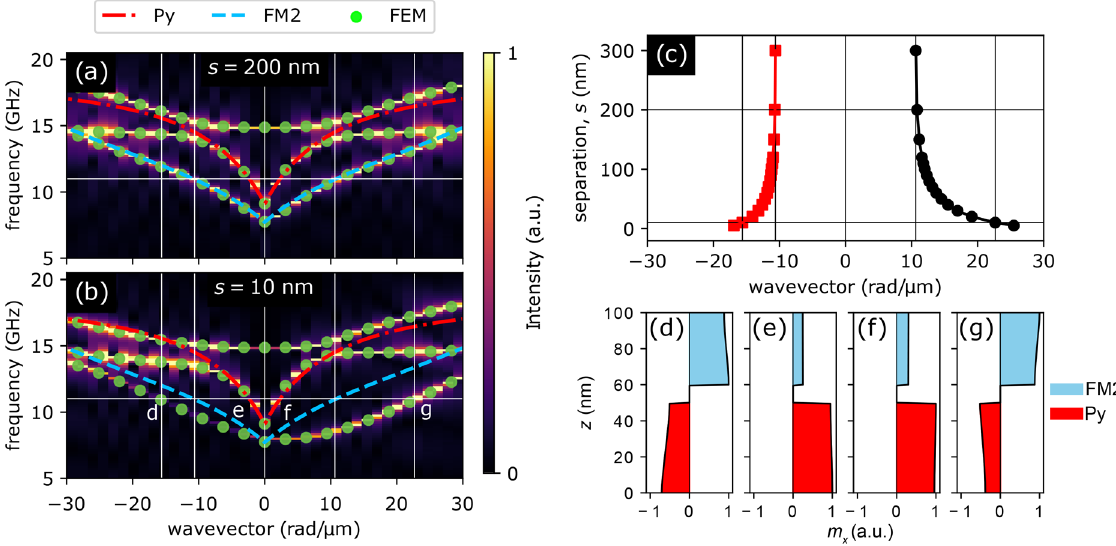
Figure 2. ( a , b ) Dispersion relations calculated for two infinite films made of Py and FM2 separated by a non- magnetic spacer of width ( a ) 200 nm and ( b ) 10 nm. Colormaps in the background present results obtained by means of micromagnetic simulations, whereas green points correspond to the results of FD-FEM calculations. The dashed blue and the dash-dotted red lines are the analytical dispersion relations of SWs supported by isolated FM2 and Py films, respectively. The horizontal line marks the frequency f = 11 GHz used in further calculations. ( c ) Dependence of the wavenumber of the slow modes, marked with d and g in ( b ), located predominantly in FM2, on the separation between films at frequency 11 GHz. ( d – g ) Profiles of the dynamic m x component of the magnetization (normalized to a maximum of 1) of the ( d ), ( g ) slow and ( e , f ) fast modes of the Py/FM2 bilayer with spacer width 10 nm at frequency 11 GHz. The positions of these modes on the dispersion diagram are marked with letters d–g in panel ( b